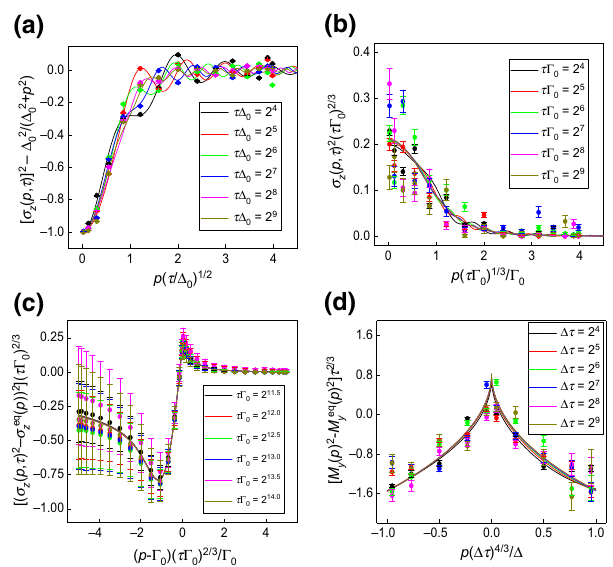
FIG. 8. The fluctuations of the defect production for different parametric ramps. The data collapse for the momentum-resolved variance (a) for the Hermitian case, (b) for the exact PT case, (c) across the non-Hermitian second-order EPs, and (d) across a fourth-order